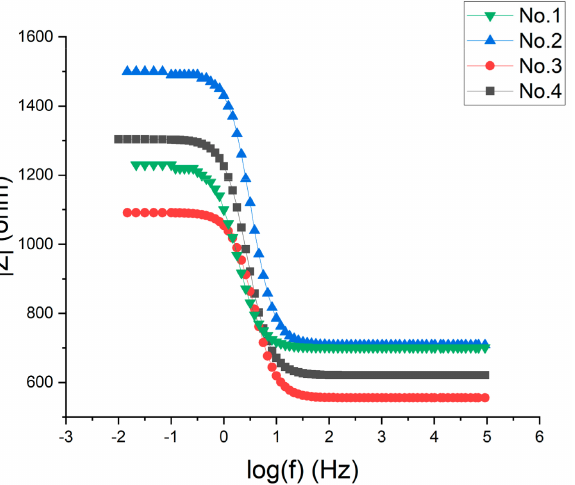
Figure 6. Bode diagram of 42CrMo alloy steel electrochemical impedance spectroscopy.